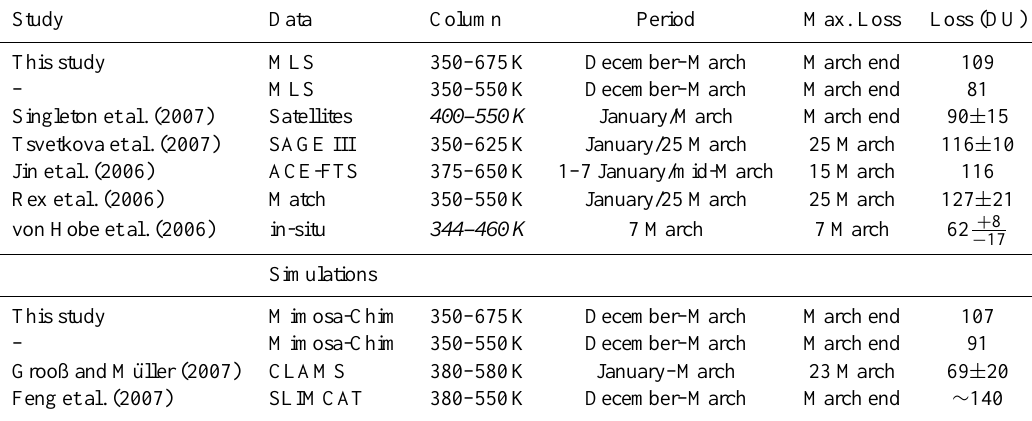
Table 3. The vortex averaged ( ≥ 65 ◦ EqL) ozone partial column loss (DU) computed from Mimosa-Chim and MLS data in 350–550K and 350–675K are compared to various results for the Arctic winter 2005. Individual vortex definition is used by each study. The error estimation provided by the respective studies are given together with the ozone loss values. Here, the column title “Period” represents the time line of individual studies and “Max. Loss” indicates the day on which the maximum ozone depletion is estimated. The column length used for the ozone loss computations are relatively small for the estimates given in italics